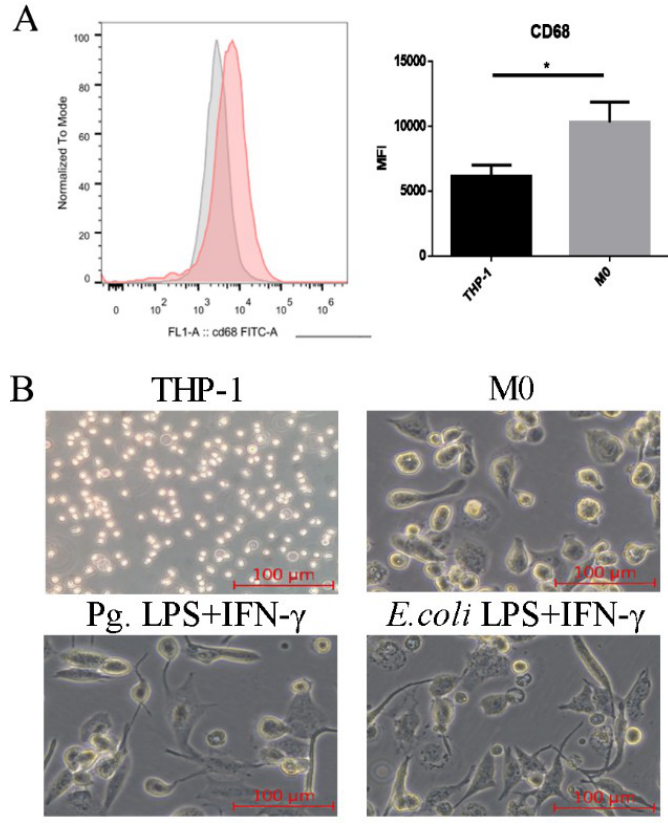
Figure 1. Differentiation of THP-1 cells to generate macrophages. ( A ) Flow cytometry analyzed the expression of CD68 by THP-1 cells and M0 macrophages. ( B ) The cells were treated with 1640 complete medium (THP-1 group), 100 ng/mL PMA (M0 group), and 100 ng/mL Pg. LPS+10 ng/mL IFN-γ or 0.1 ng/mL E. coli LPS+10 ng/mL IFN-γ for 24 h. Morphological changes were visualized by a phase contrast inverted microscope under 100 x magnification. All of the results represent the mean ± standard deviation of three independent experiments ( n = 3). * p < 0.05 indicates a significant difference compared with the control.